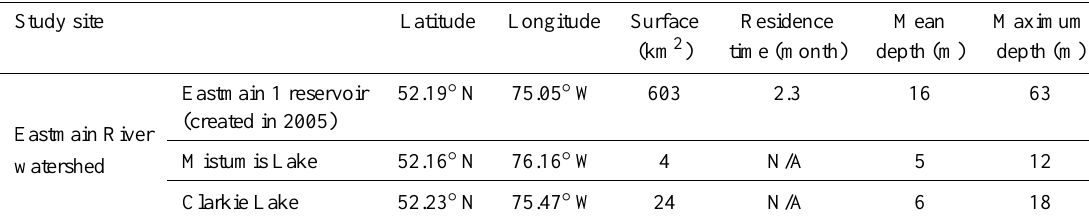
Table 1. Description of study site. Study